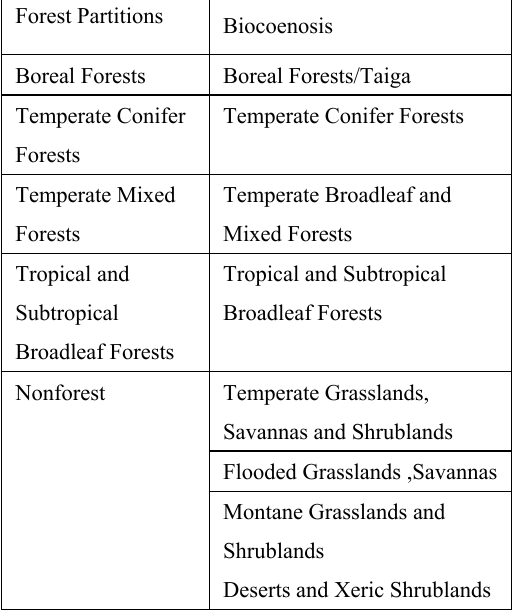
Table 1. Mapping relation between forest partitions and biocoenosis